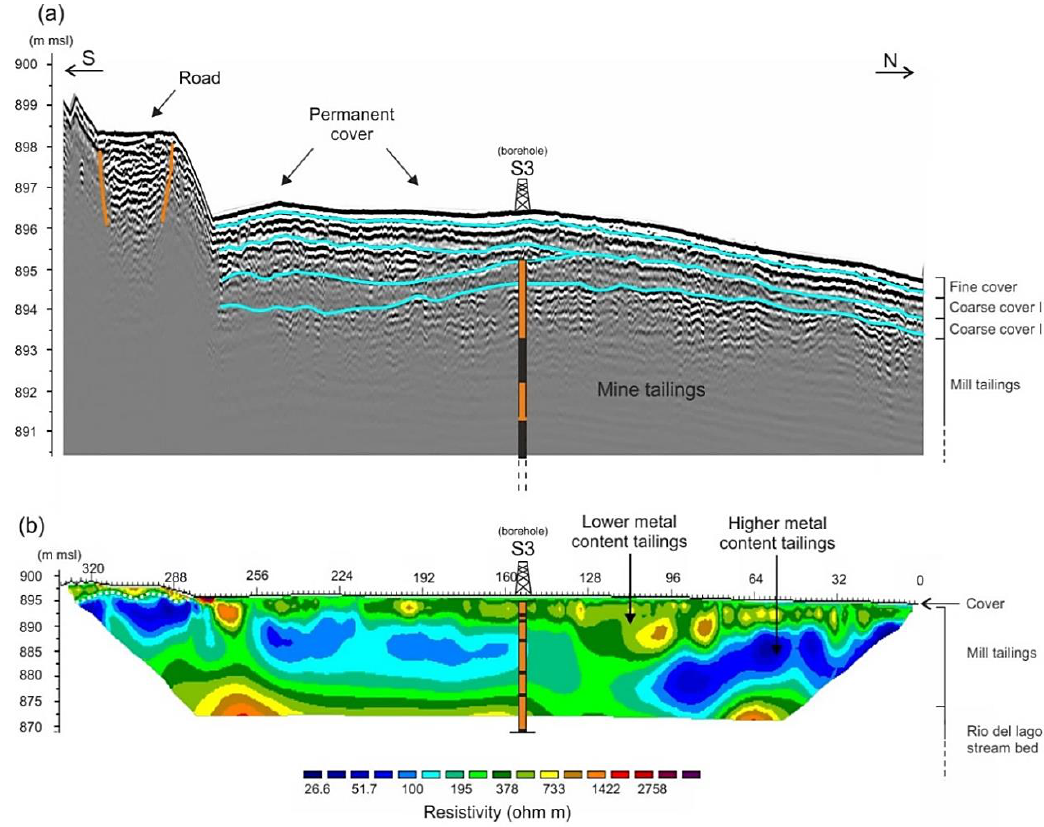
Figure 3. ( a ) GPR profile P1; ( b ) ERT profile P1. The samples analysed from the s3 borehole are reported in Figure 5.